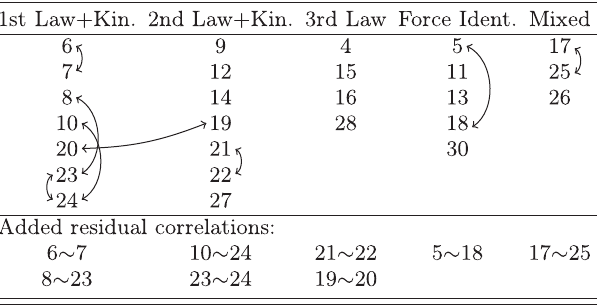
TABLE III. The factor model developed by Eaton and Wil- loughby. The added residual correlations were due to suggested modification indices and from expert consideration of the questions themselves. The numbers in the table indicate the question numbers from the 1995 FCI, and the double headed arrow and the ∼ symbol represent an estimated correlation for those two questions within the